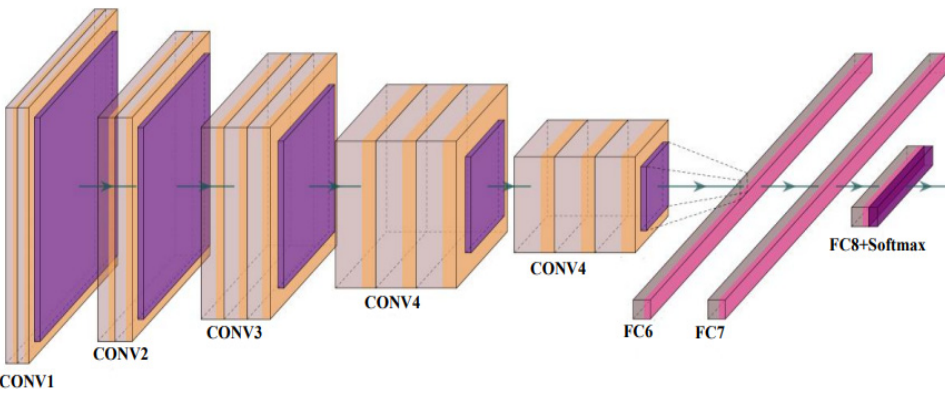
Figure 6. ResNet with residual block.